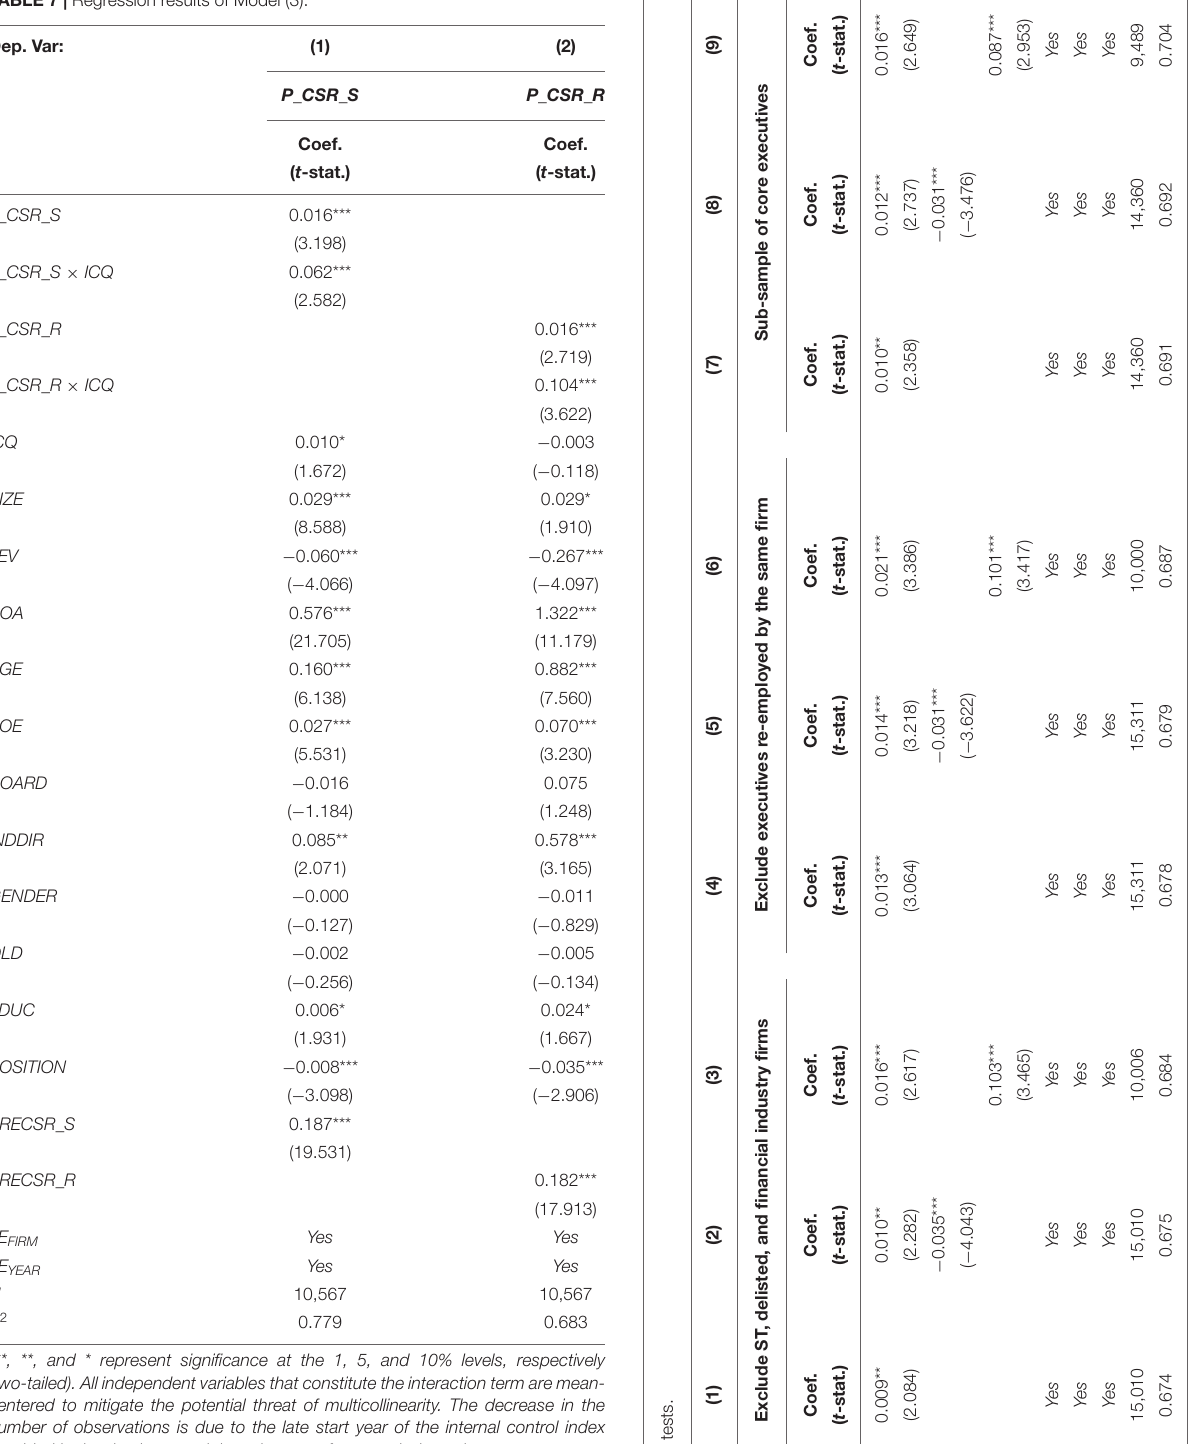
TABLE 7 | Regression results of Model